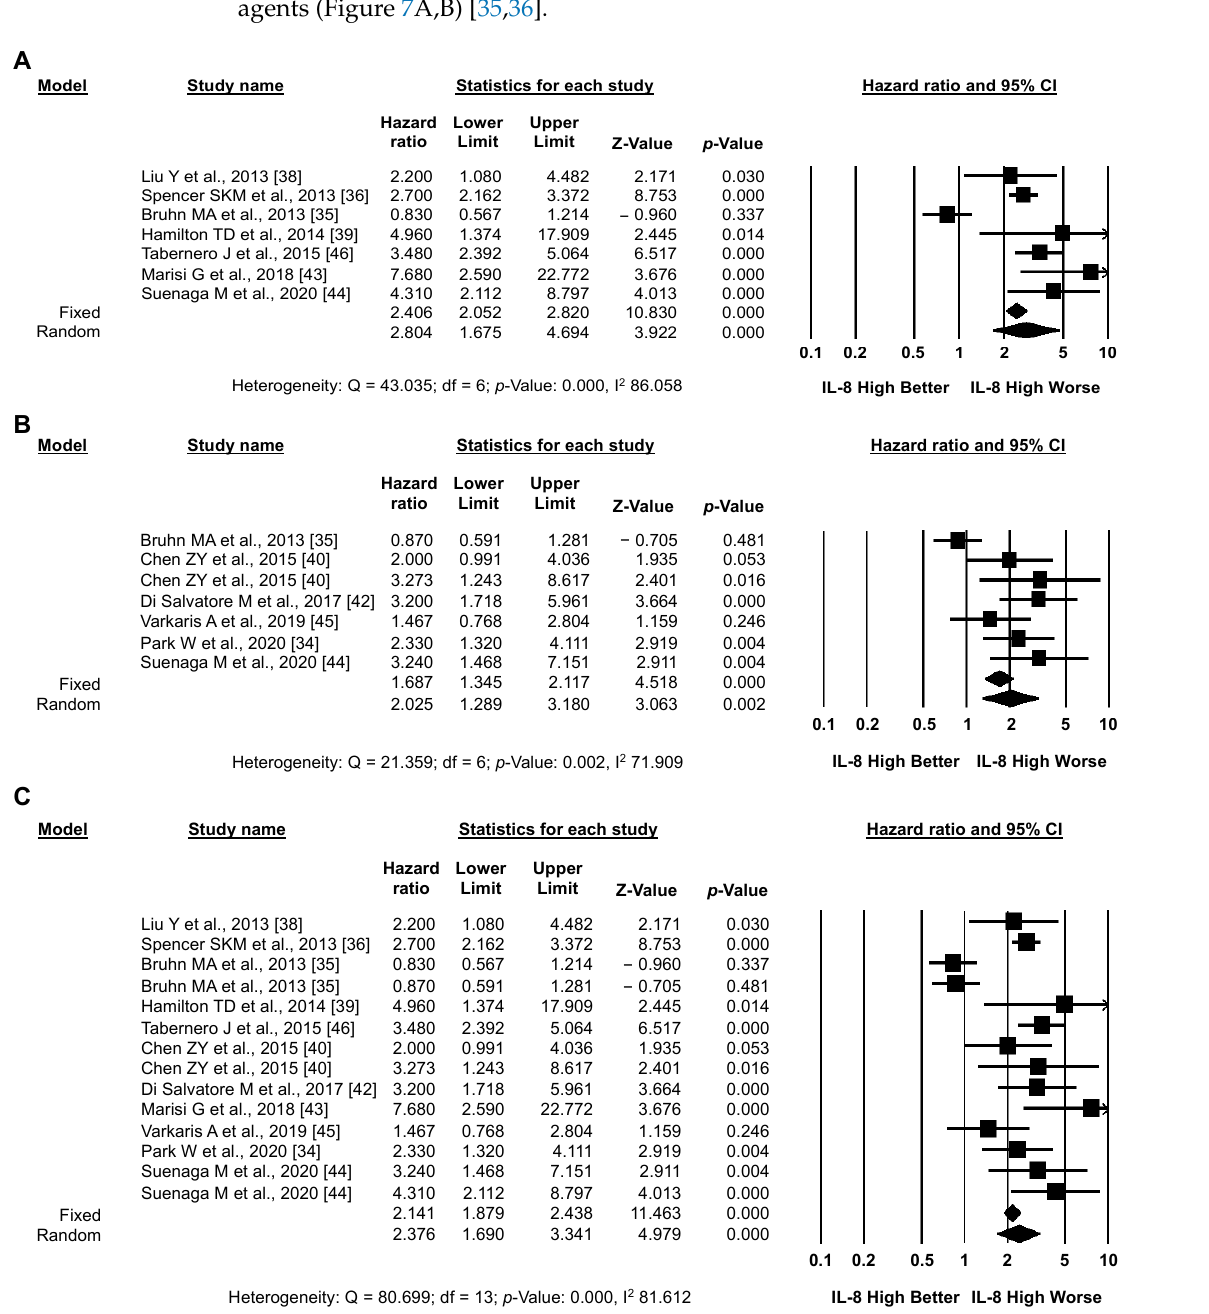
Figure 6C), without heterogeneity (I2: 0.000). No data on PFS were available in these studies. No significant effect of IL-8 expression on either OS or PFS was observed in the two series (783 patients) that included CRC patients treated both with and without anti-angiogenic agents (Figure 7A,B) [35,36].